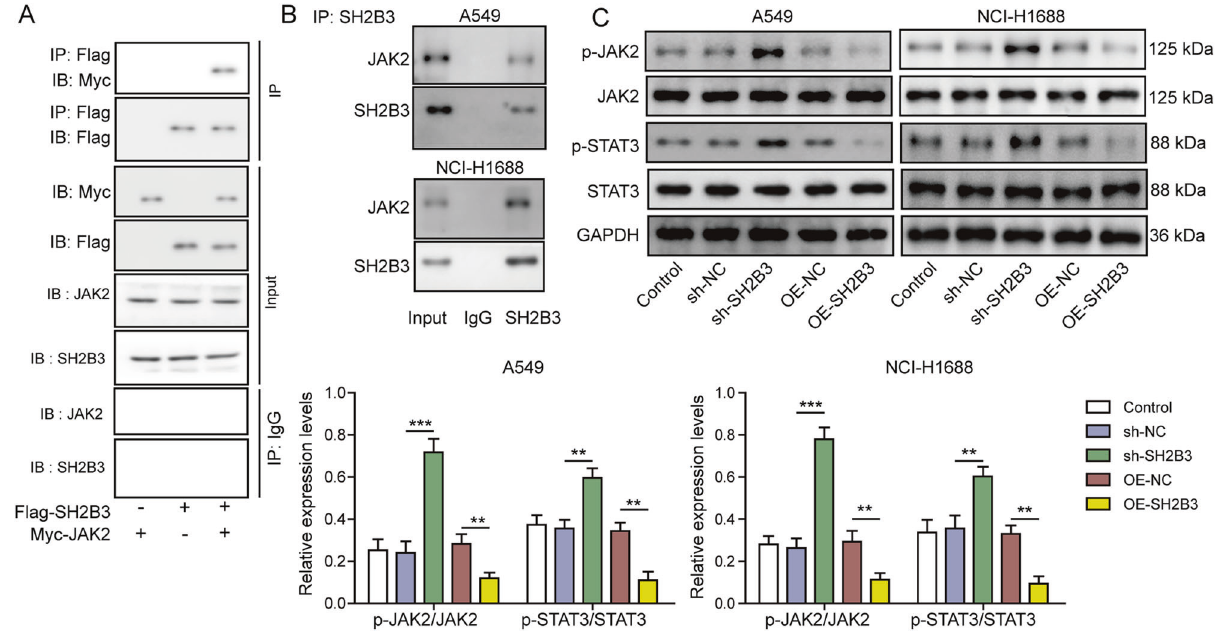
Fig. 4 SH2B3 bound to JAK2 and suppressed JAK2/STAT3 signaling. A Immunoblotting for Flag, Myc, JAK2, and SH2B3 following immunoprecipitation with Flag antibody in transfected cells. B Immunoblotting for JAK2 following SH2B3 immunoprecipitation in cancer cells. C Western blotting to determine protein levels of p-JAK2, JAK2, p-STAT3, and STAT3 in transfected cancer cells. *** P < 0.001 and ** P <